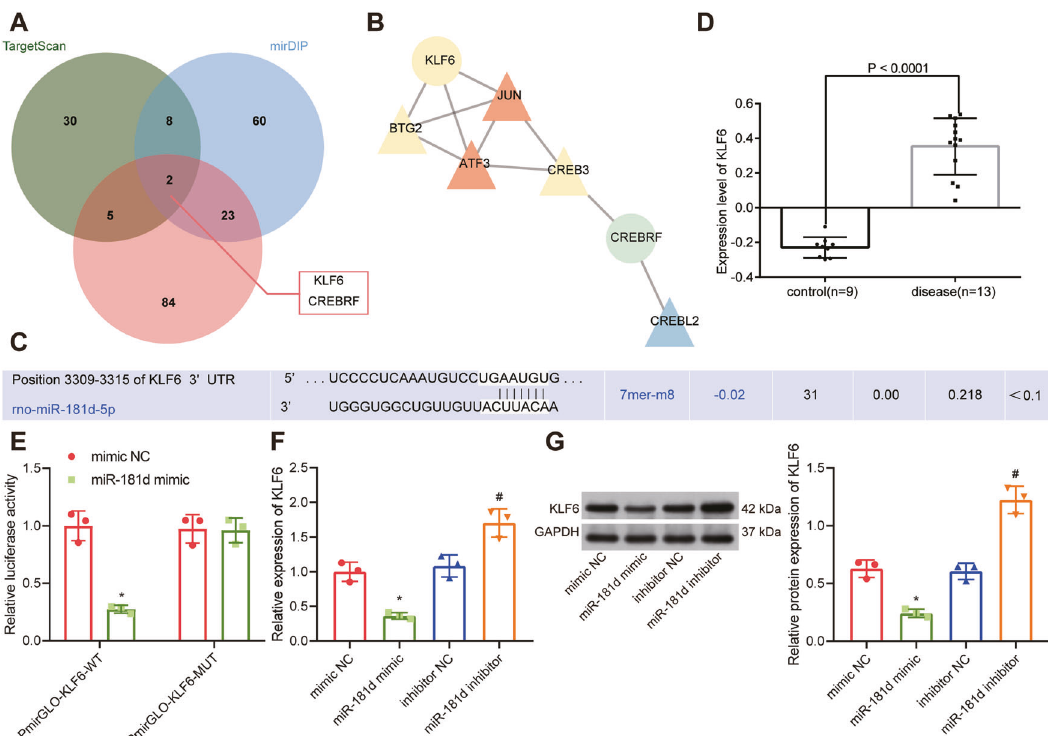
Fig. 4 miR-181d targets KLF6. A A Venn diagram of the downstream targets of miR-181d predicted by the TargetScan, mirDIP and DIANA tool websites. B PPI networks for CREBRF and KLF6 and their related genes constructed using the String website. The circle indicates the input gene, and the triangle indicates the predicted related gene. The gene with redder color presented higher degree of correlation, while the gene with bluer color had lower degree of correlation. C The binding site between miR-181d and KLF6 was predicted using the Targetscan website. D A box line diagram based on the KLF6 expression data from the GSE36496 dataset. The blue box on the left represents the expression of normal control samples, and the red box on the right represents the expression of renal fi brosis samples. E miR-181d targeting of KLF6 is veri fi ed by dual luciferase reporter gene assay. * p < 0.05 vs . mimic NC. F RT-qPCR analysis of KLF6 mRNA expression in HK-2 cells after overexpression or silencing of miR-181d. * p < 0.05 vs . mimic NC. # p < 0.05 vs . inhibitor NC. G Western blot analysis of KLF6 expression in HK-2 cells after overexpression or silencing of miR-181d. * p < 0.05 vs . mimic NC. # p < 0.05 vs . inhibitor NC. The cell experiment was repeated three independent